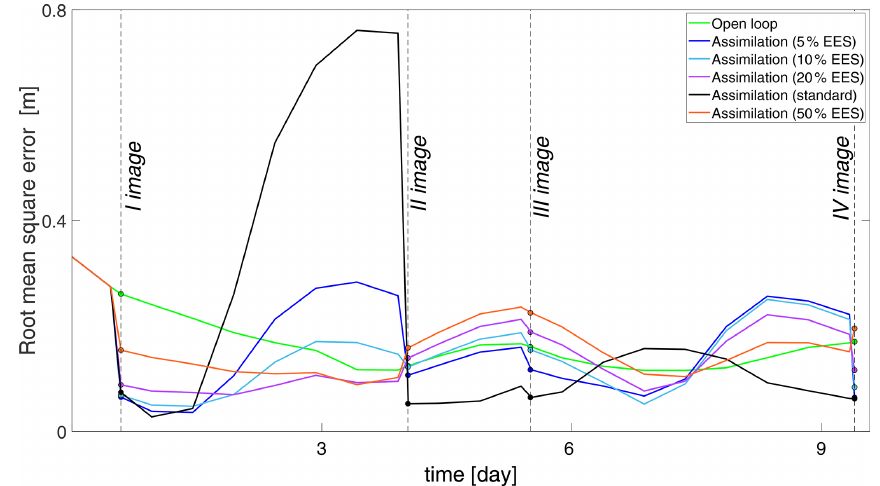
Figure 9. Time series of root mean square error (RMSE [m]) values for the different assimilation experiments: open loop (green), standard assimilation (black), assimilations with 5% EES (blue), 10% EES (cyan), 20% EES (purple), and 50% EES